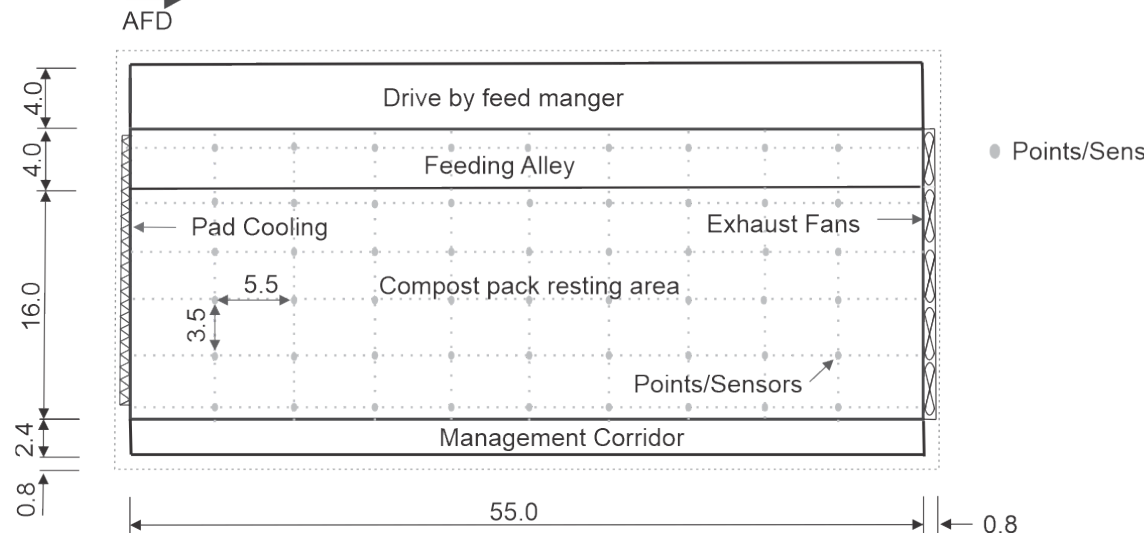
Figure 2. Schematic representation of the collection points inside the compost bedded pack barn (CBP). *AFD – Air flow direction. Dimensions in meters (m). Subtitle: